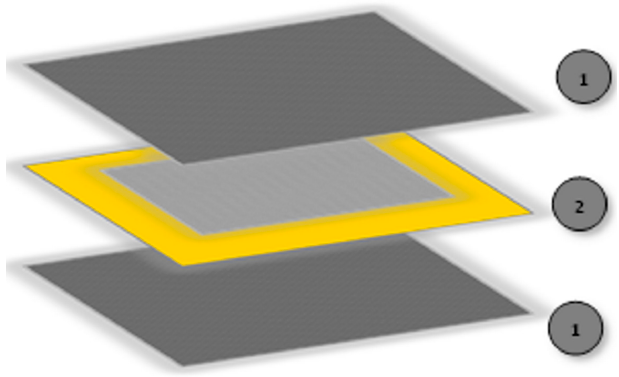
Figure 4. Schematic representation of MEA layers: ( 1 ) GDLs; and ( 2 ) CCM.